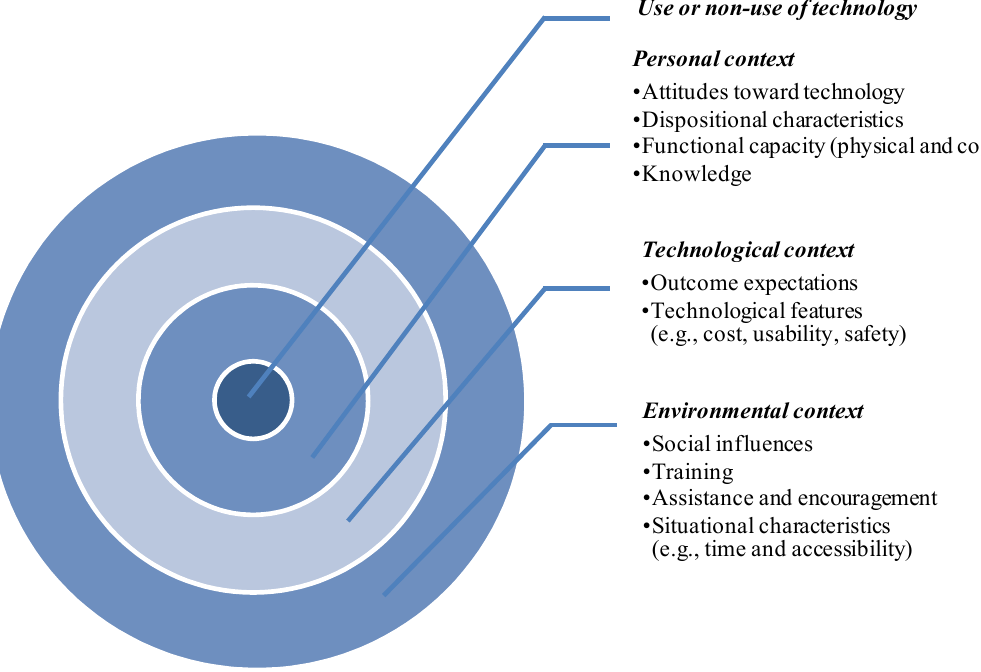
Figure 2. The grounded model based on qualitative